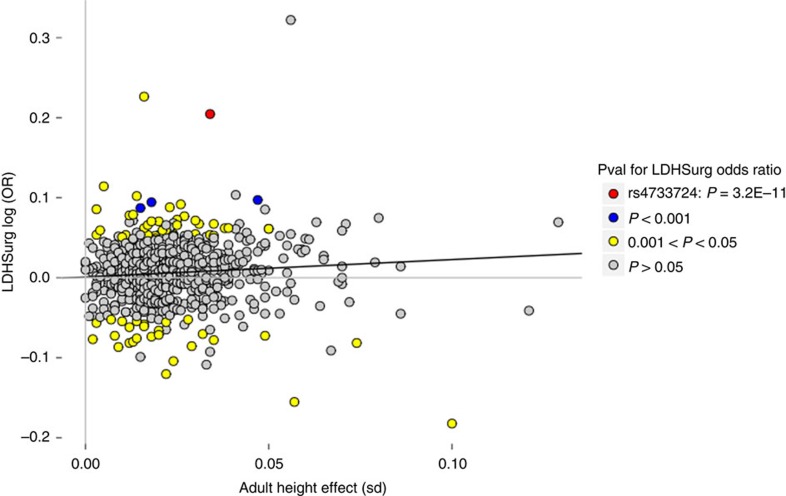
Correlation of GIANT variants' effect on height and risk of LDHsurg.Scatter plot showing how the 689 out of 697 adult height variants reported by GIANT37 that we have LDHsurg association results for, affect adult height (x axis) and LDHsurg (y axis) in our data. The effect allele (minor or major) of each variant was concluded to be the one that has a positive effect on adult height in our data. The black solid line, y=0.0010+0.22x+e, represents weighted linear regression, excluding rs4733724, with R2=0.0072 and P=0.026, using MAF(1-MAF) as weights. A t-test was used to calculate P value.